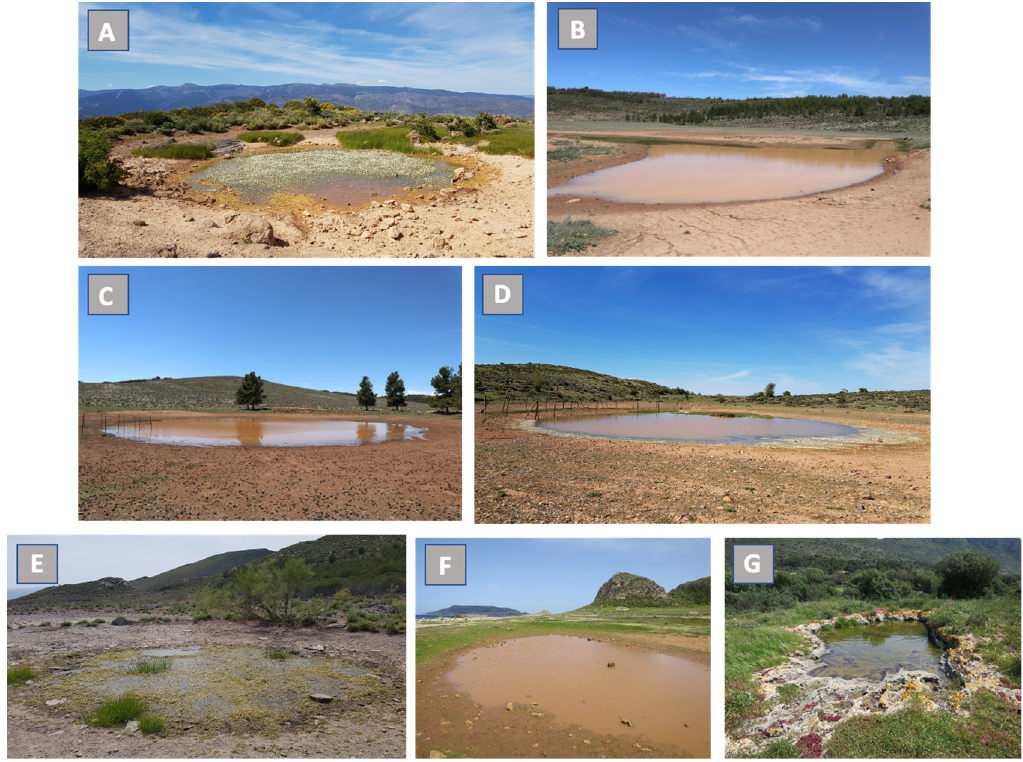
Figure 2. ( A ) Balsa Blanca; ( B ) Balsa de Caparidán; ( C ) Balsa del Sabinar; ( D ) Balsa de Barjalí; ( E ) Charca de Filabres; ( F ) Pozze dell’Ucceria (TP072); ( G ) Pozza di Grotta del Piano (TP185).